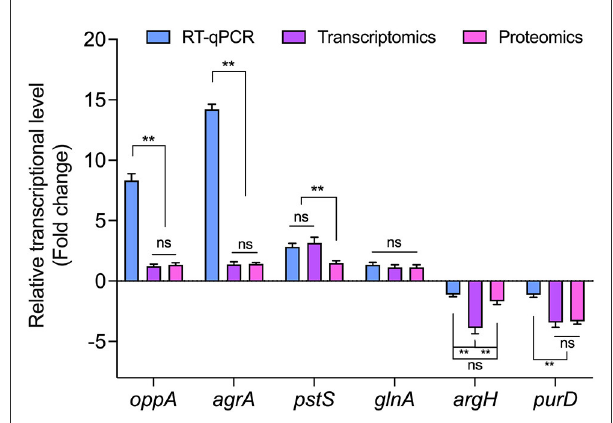
FIGURE6 The relative expression of genes encoding DEPs in L. paraplantarum RX-8 under co-culture. ns, not significant, ** p <